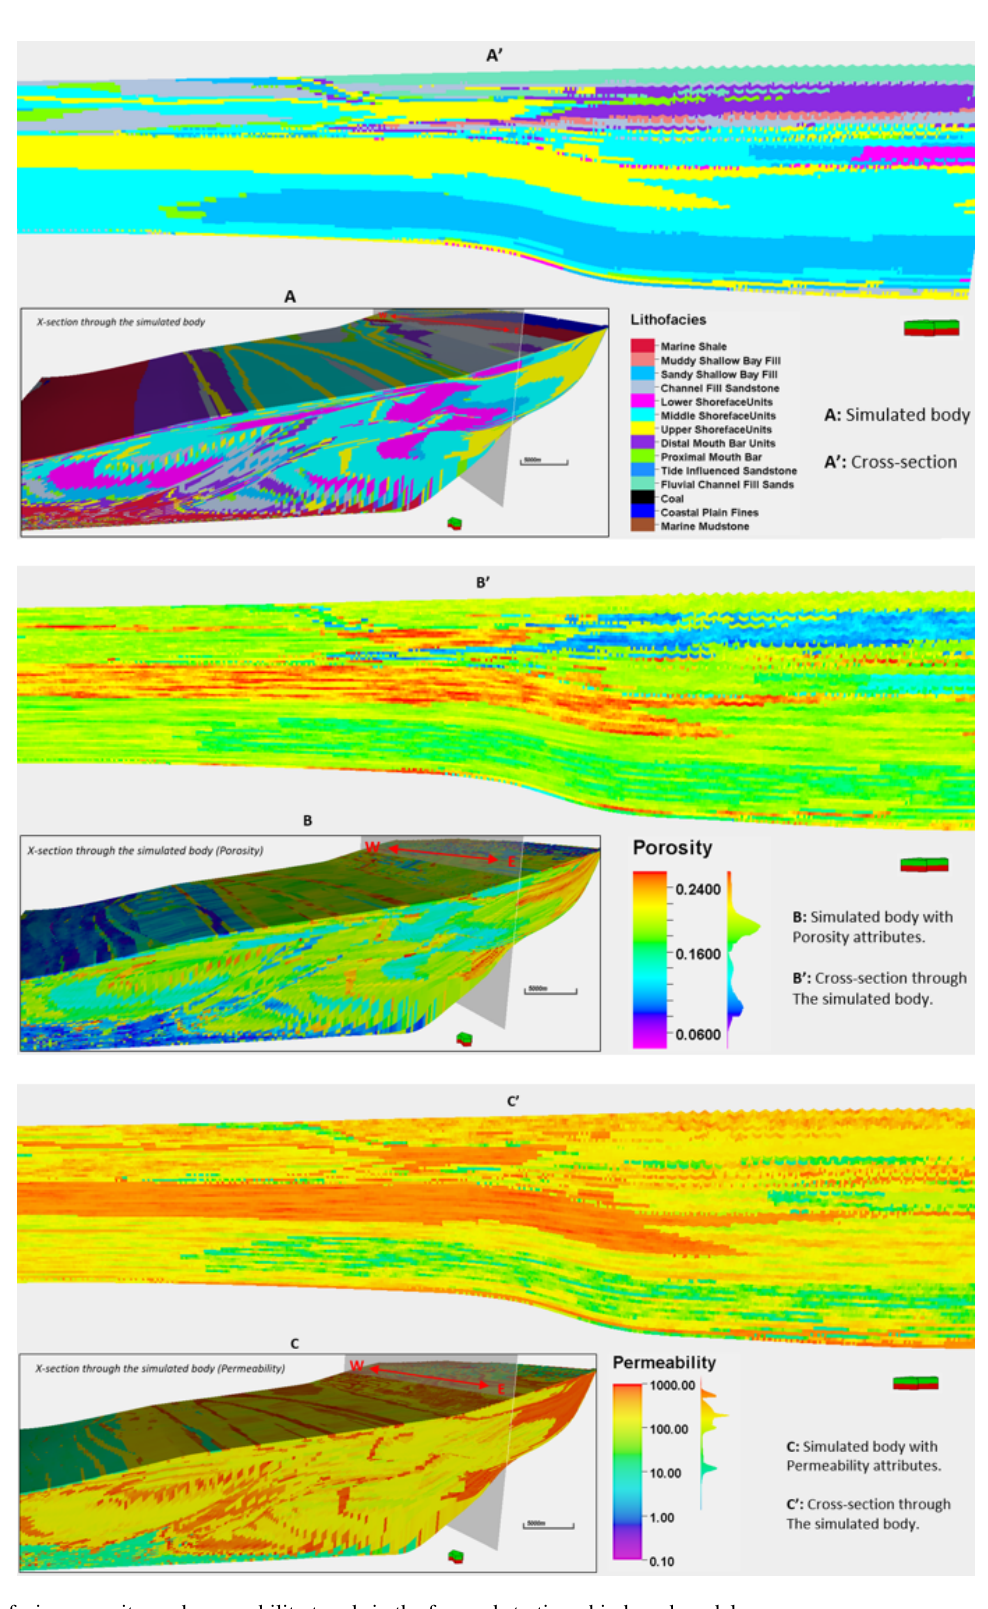
Figure 8. Lithofacies, porosity, and permeability trends in the forward stratigraphic-based models.